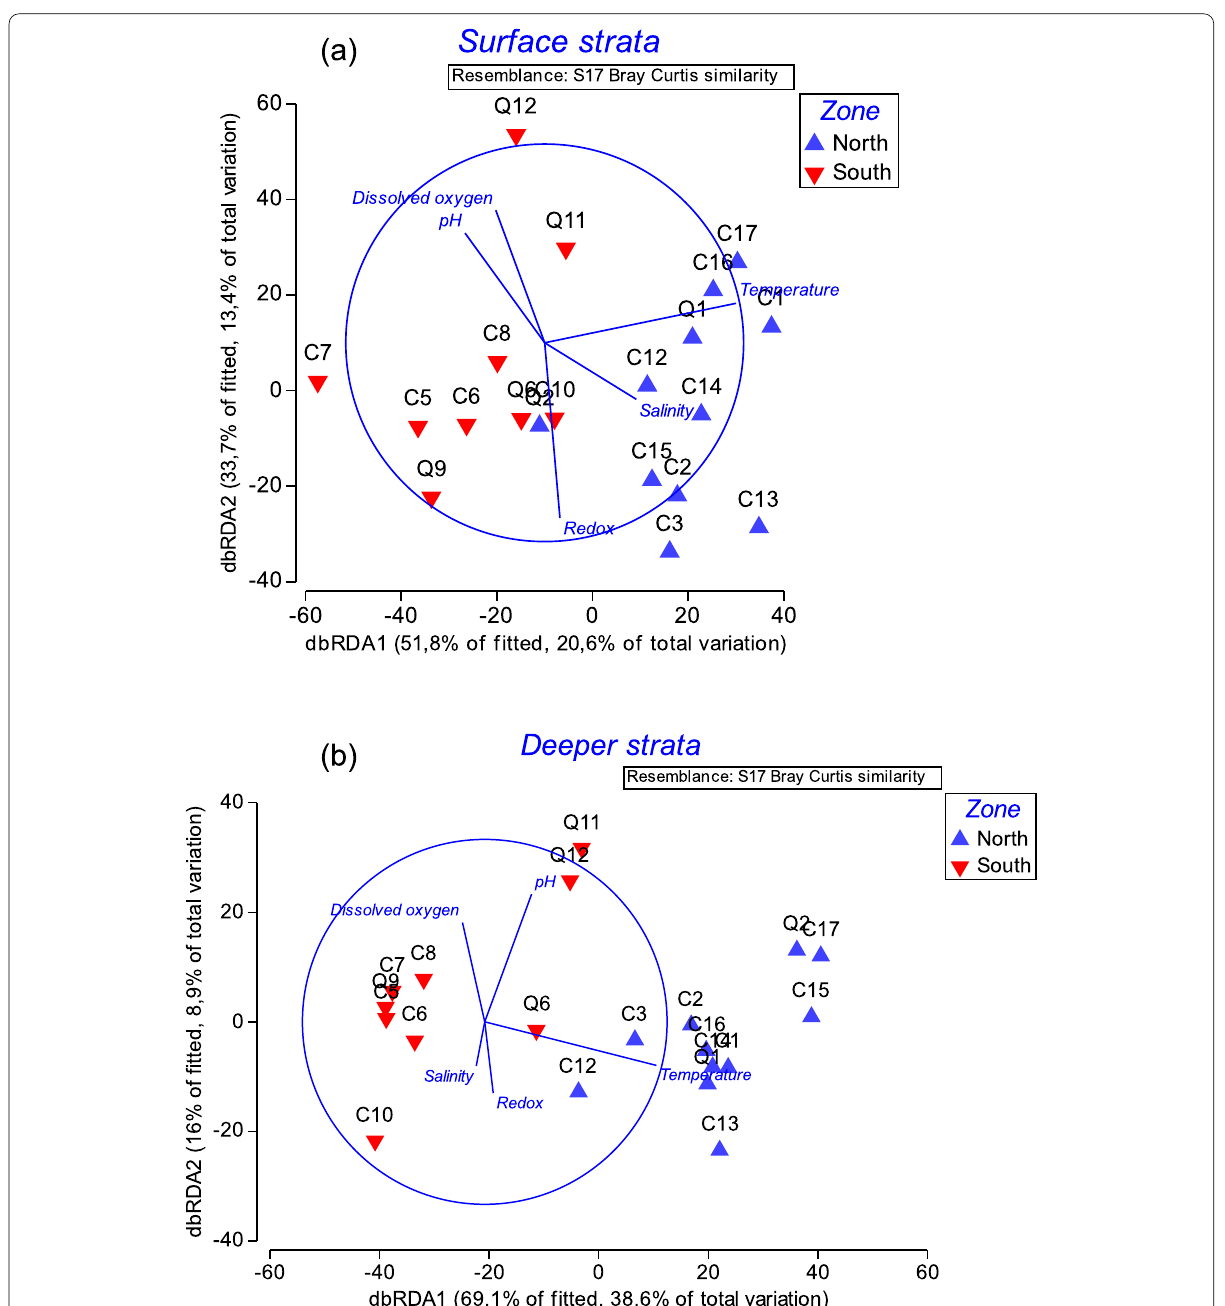
Fig. 5 Graphical output of dbRDA analyses for ( a ) surface and ( b ) deeper strata. Multivariate arrangement of zooplankton community is shown in each plot. In both cases Bray–Curtis similarity measure without transformation is presented. Vectors of environmental variables are superimposed, showing Pearson correlation between scores of each dbRDA axis with each environmental